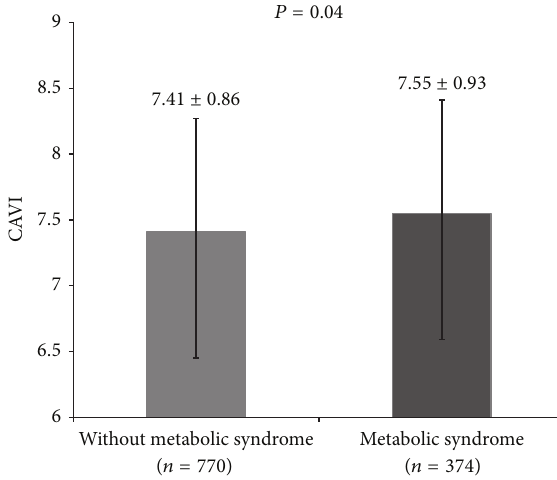
Figure 1: Comparison of cardioankle vascular index (CAVI) between subjects with and without metabolic syndrome. 𝑃 values were calculated by ANCOVA and age-adjusted